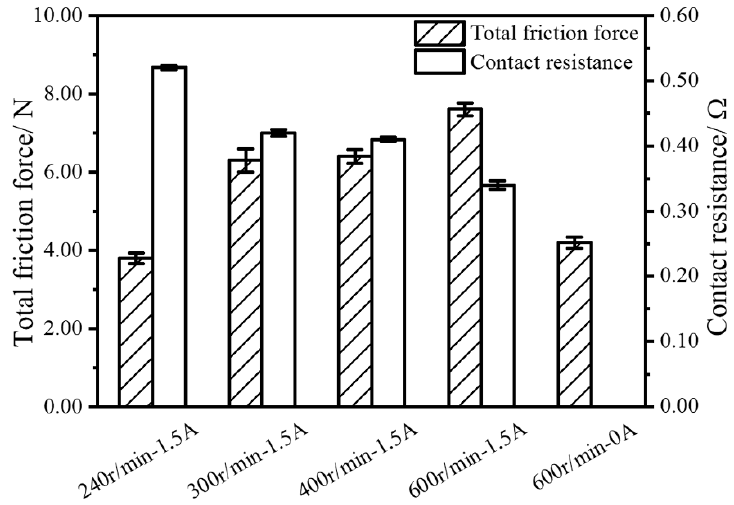
Figure 8. The total friction force and contact resistance at steady-state with different rotation speeds [54].